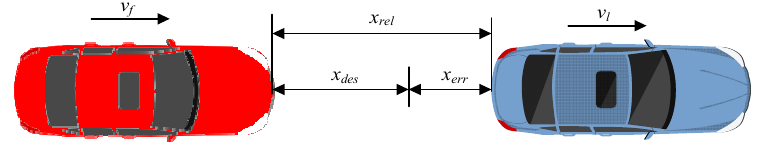
Figure 6. Vehicle-following scenario.